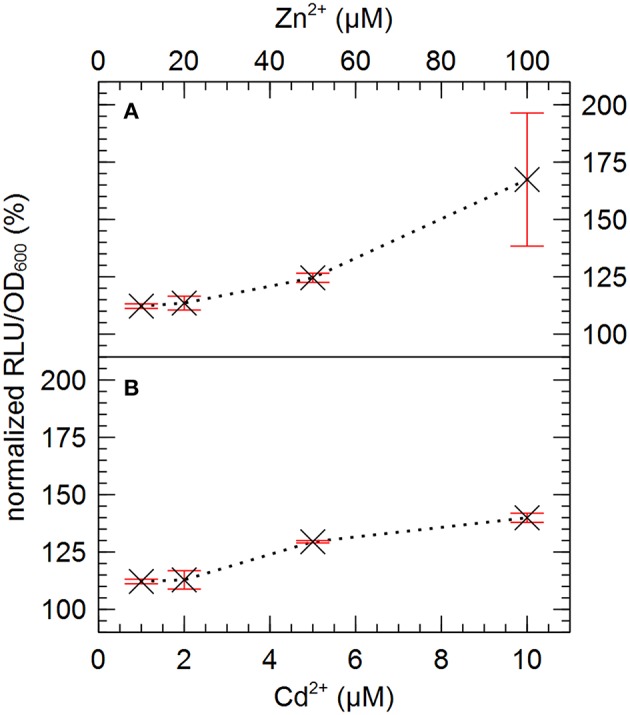
Normalized dose-response curve for the transcription of the endogenous promoter of ISRme5 in response to zinc (A) and cadmium (B) measured after 4 h of incubation. The average values of three independent experiments with standard deviations are shown.